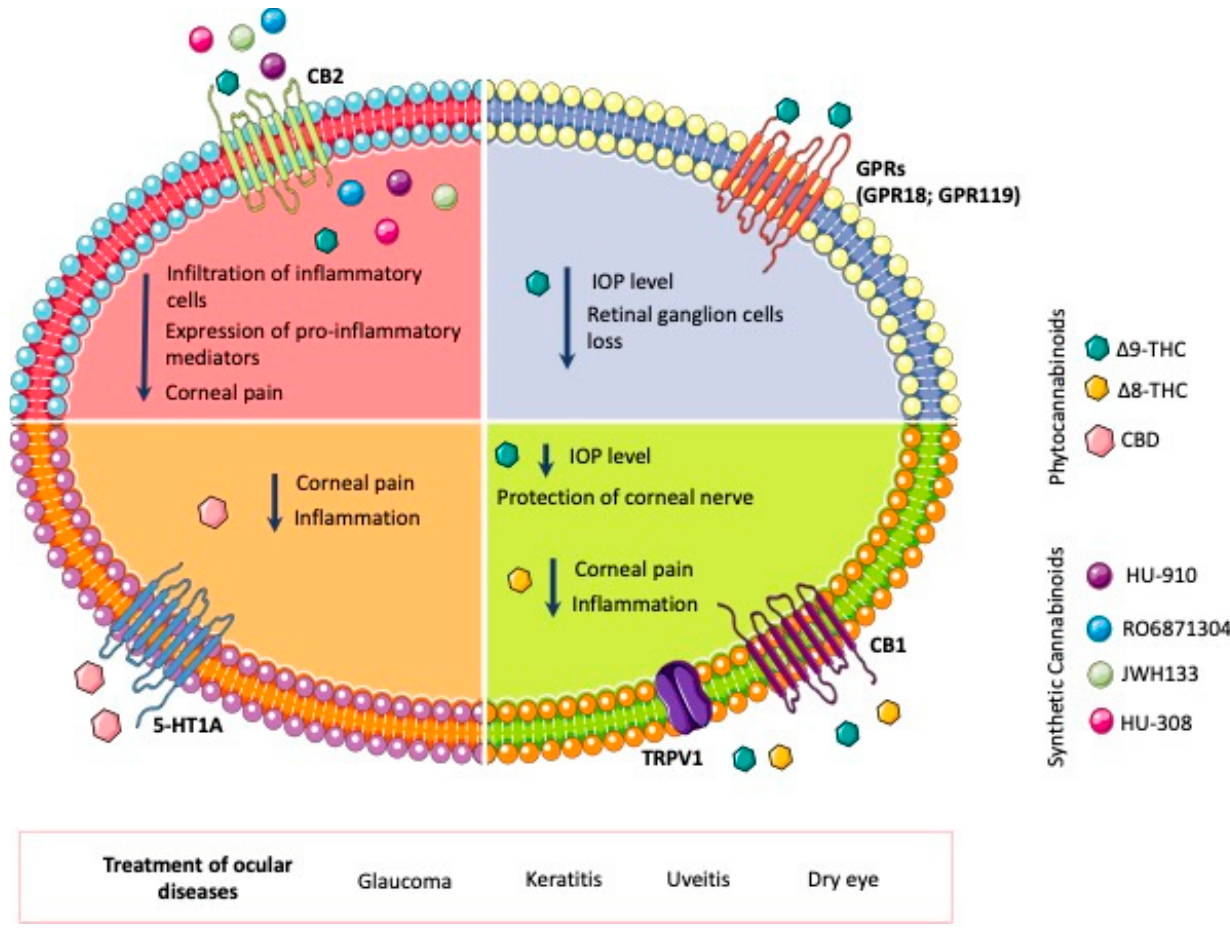
Figure 1. Cannabinoid signaling pathways and effects. Regardless of the type of cannabinoid ligand (phytocannabinoid, endocannabinoid or synthetic), these compounds primarily interact with G protein-coupled receptors (GPCR), such as the CB1 and CB2 receptors and GPR55, or with transient receptor potential (TRP) channels, such as TRPV1, to induce a cellular response. The activated pathways vary based upon receptor activation and have physiological effects on pain, inflammation and intraocular pressure levels, among other effects.